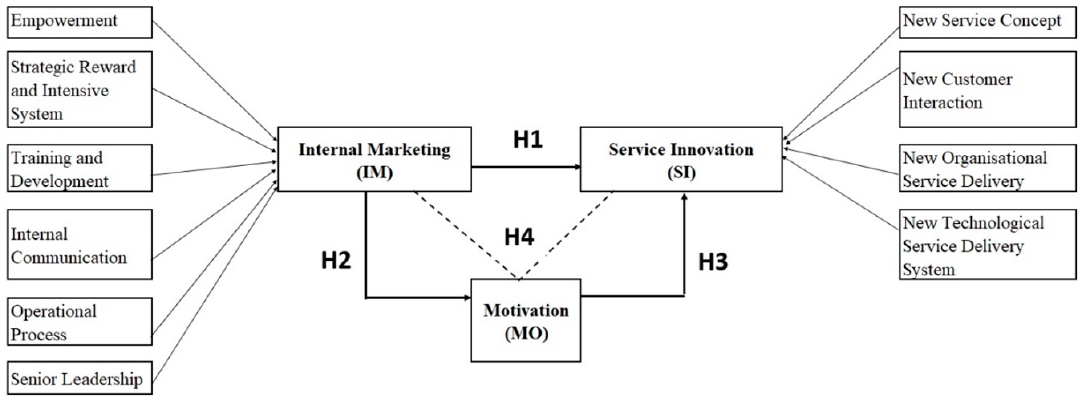
Figure 1. Proposed research framework.